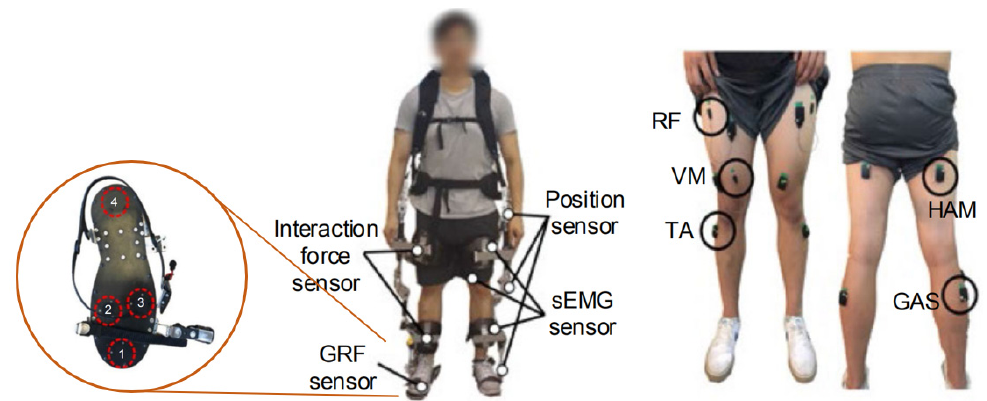
Figure 11. Multisensory fusion strategy using EMG, kinematic sensors, and kinetic sensors together for the application of rehabilitation exoskeleton, adopted from [122].